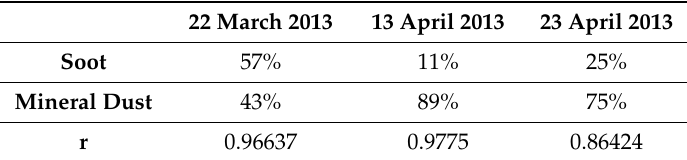
Table 1. The second bin (0.25 µ m < r < 0.5 µ m) is taken to be a mixture of soot and mineral dust. Table 1. The second bin ( 0.25𝜇𝑚 < 𝑟 < 0.5𝜇𝑚 ) is taken to be a mixture of soot and mineral dust. The Table 1. The second bin ( 0.25𝜇𝑚 < 𝑟 < 0.5𝜇𝑚 ) is taken to be a mixture of soot and mineral dust. The Table 1. The second bin ( 0.25𝜇𝑚 < 𝑟 < 0.5𝜇𝑚 ) is taken to be a mixture of soot and mineral dust. The The given percentages on this table lead to the highest Pearson correlation coe ffi cient, as represented given percentages on this table lead to the highest Pearson correlation coefficient, as represented on given percentages on this table lead to the highest Pearson correlation coefficient, as represented on given percentages on this table lead to the highest Pearson correlation coefficient, as represented on on the last the last row. the last row. the last row.